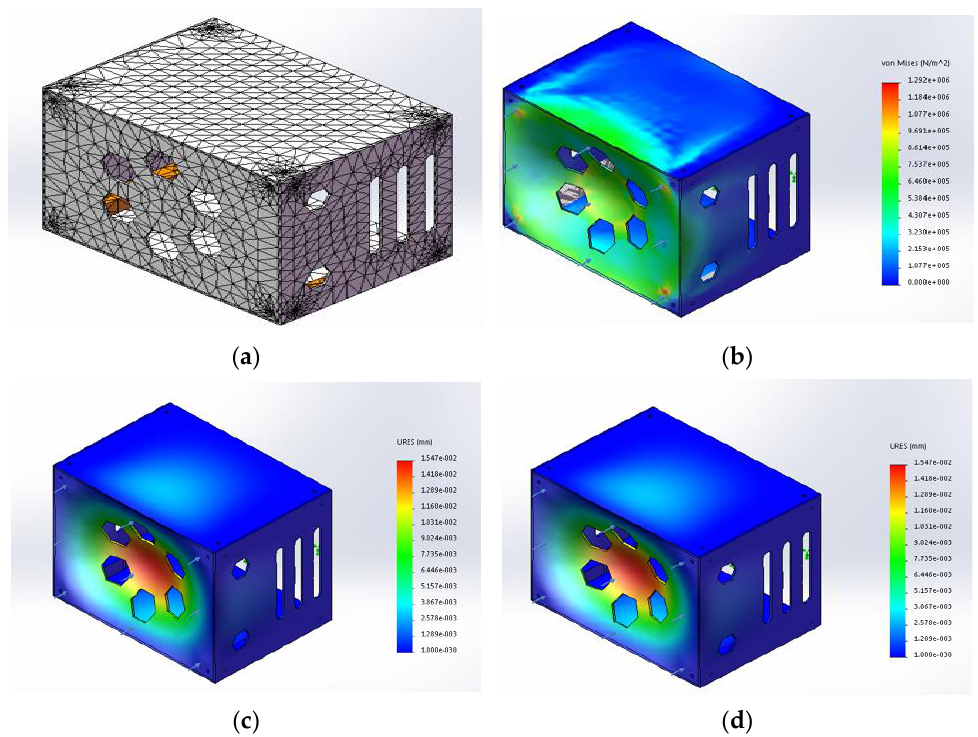
Figure 2. ( a ) Head structure meshing. ( b ) Equivalent stress cloud diagram of head structure. ( c ) Equivalent displacement cloud diagram of head structure. ( d ) Equivalent displacement cloud diagram of head structure.